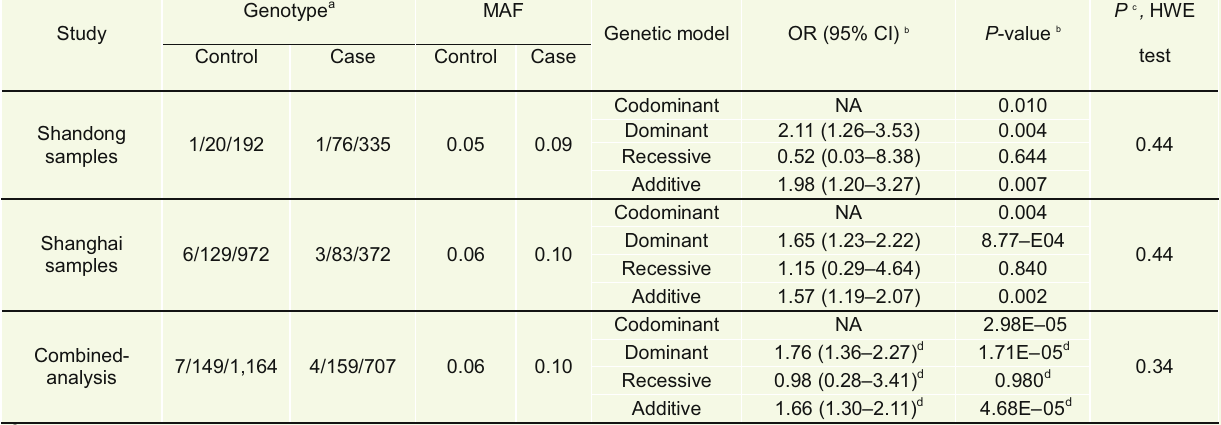
Table 1. Association of SNP rs2243890 A>G in RCAN1.4 promoter region with CHDs in two independent case-control